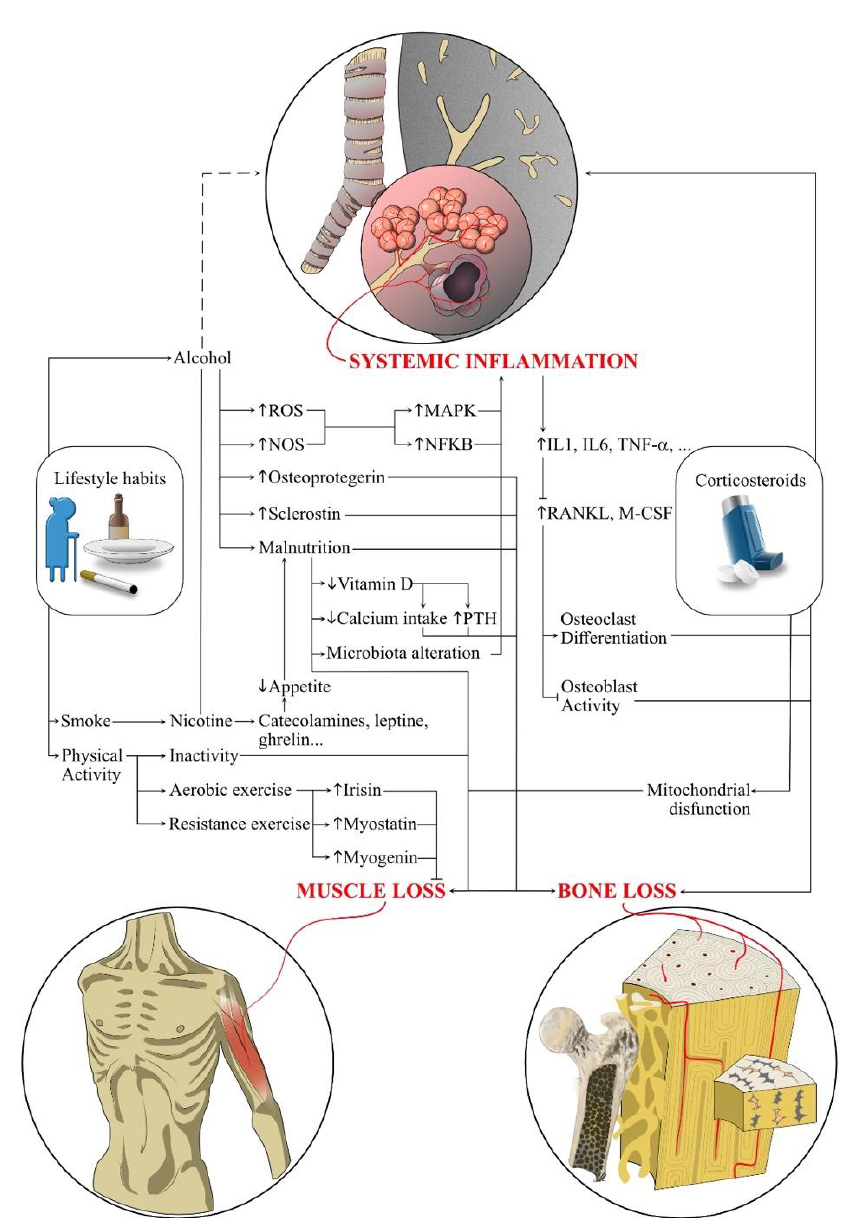
Figure 1. This figure lists the most important pathways involved in the pathophysiology of COPD, osteoporosis, and sarcopenia. Abbreviations: IL-(n): interleukin-n; MAPK: mitogen-activated protein- kinase; M-CSF: macrophage-colony stimulation factor; NFKB: nuclear factor kappa-light-chain- enhancer of activated B cells; NOS: nitric oxide synthase; PTH: parathyroid hormone; RANKL: receptor activator of nuclear factor kappa-B ligand; ROS: reactive oxygen species; TNF- α : tumour necrosis factor- α.